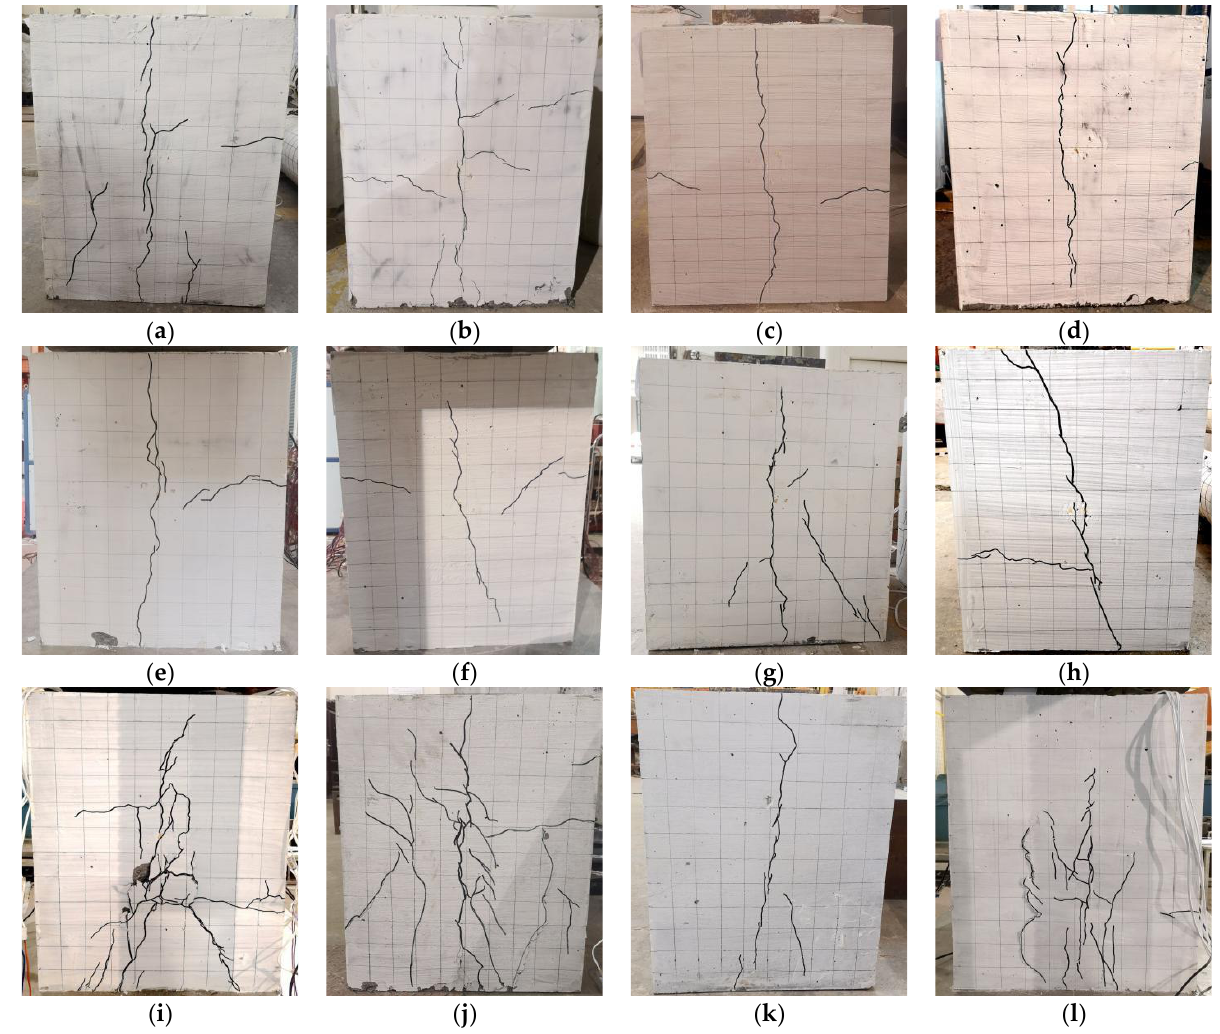
Figure 7. Cracking patterns of the concrete blocks: ( a ) P-1; ( b ) P-2; ( c ) P-3; ( d ) P-4; ( e ) P-5; ( f ) LP-1; ( g ) HP-1; ( h ) NP-1; ( i ) SP-1; ( j ) CP-1; ( k ) CP-2; ( l ) CP-3.